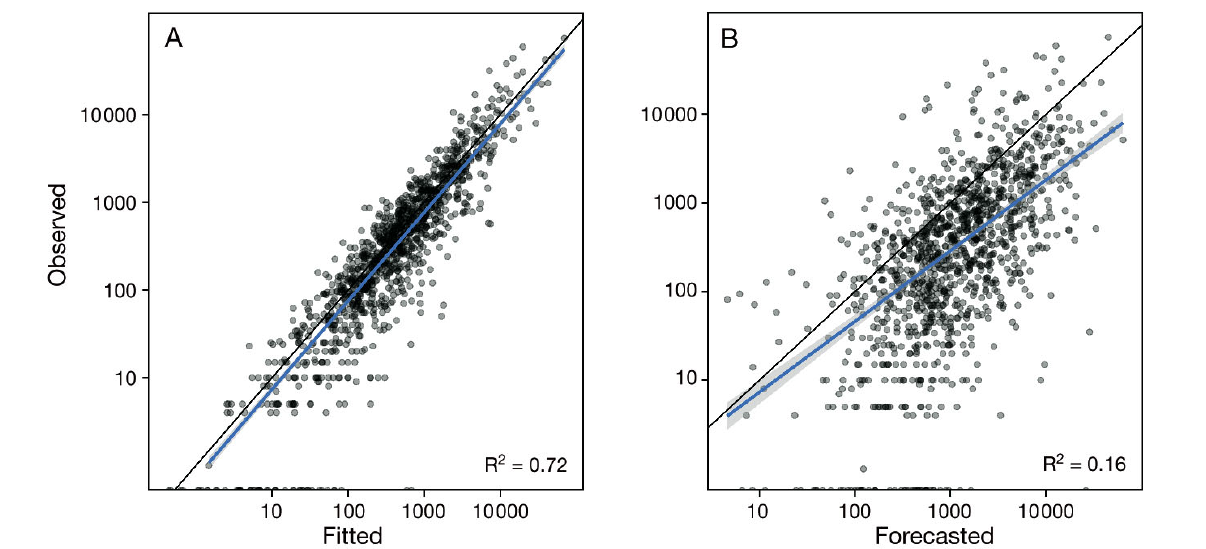
Fig. 5. (A) Fitted counts and (B) counts forecasted 1 mo ahead versus observed counts of Mytilus spat m −1 . Due to the over- dispersed Mytilus distribution, both axes are log-scaled to aid in the visualisation of the relationships. The blue lines are ordi- nary least square regressions; grey shading represents 95% pointwise confidence intervals of the fitted values. The black lines are the one-to-one